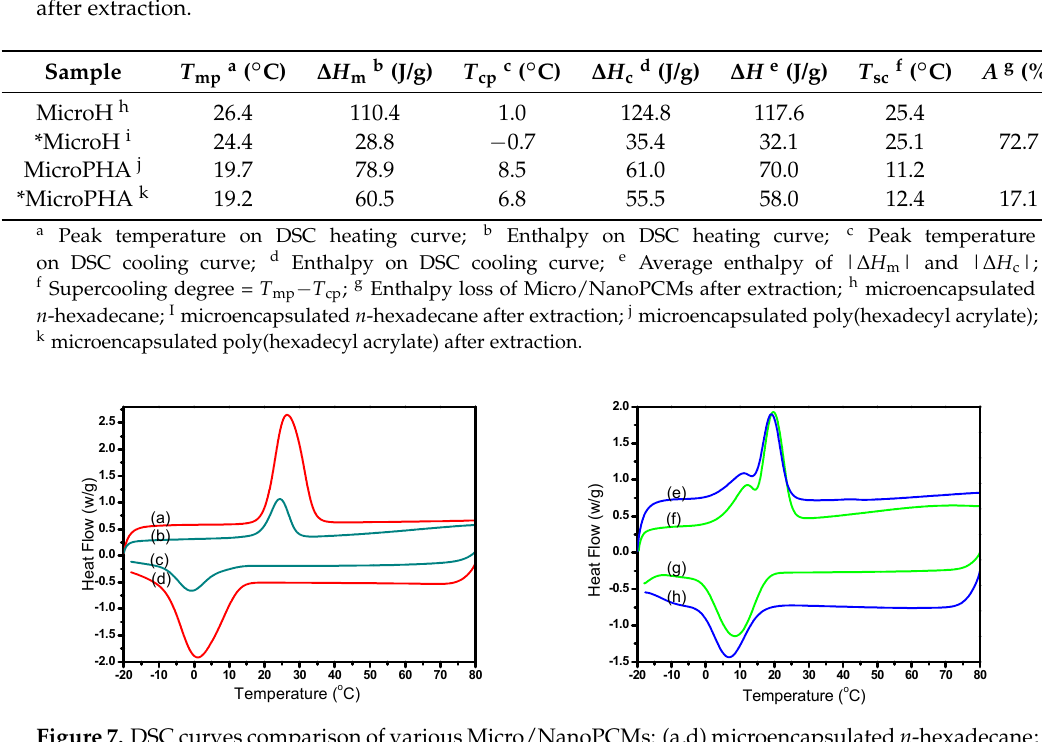
Table 3. Phase change performance comparison of Micro/NanoPCMs between before extraction and after extraction.